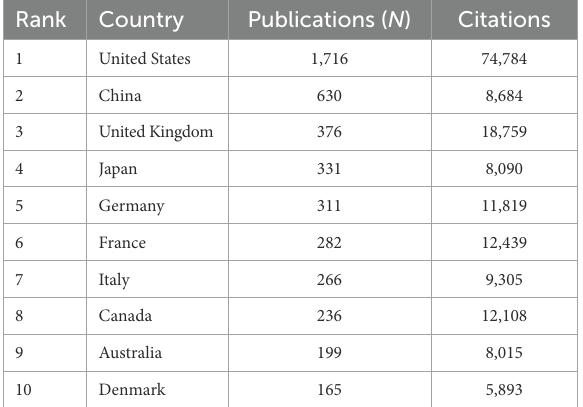
TABLE 2 The top 10 productive countries.